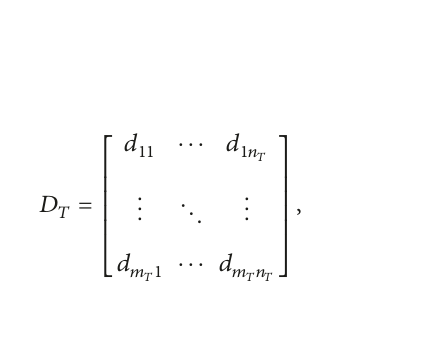
Figure 3: Research